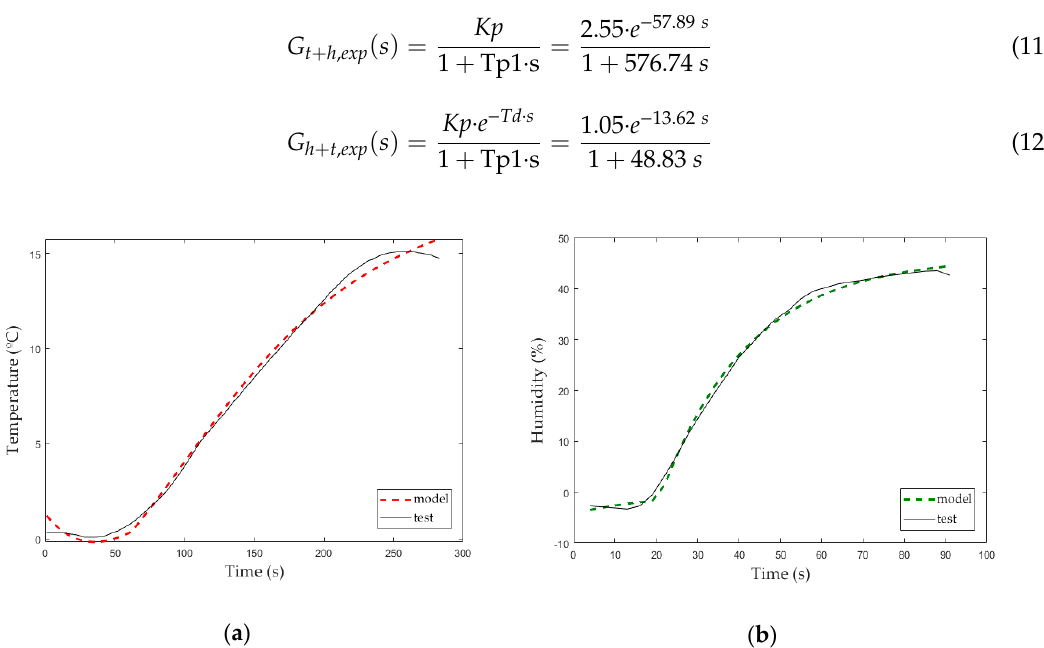
Figure 9. ( a ) SISO temperature study, ( b ) SISO humidity study.